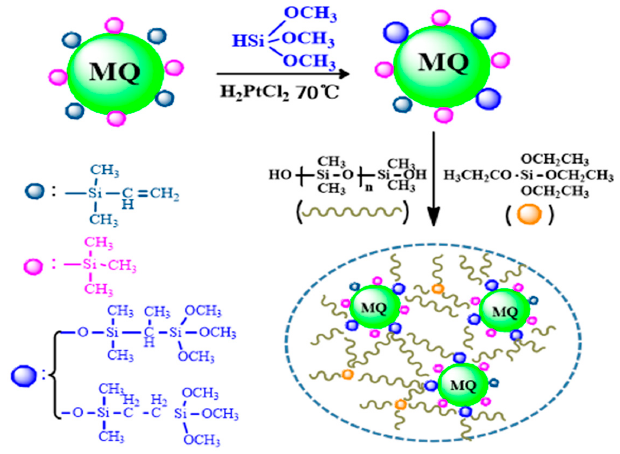
Figure 1. Prepared route of RTV silicone rubber using MMQ as a cross-linker.